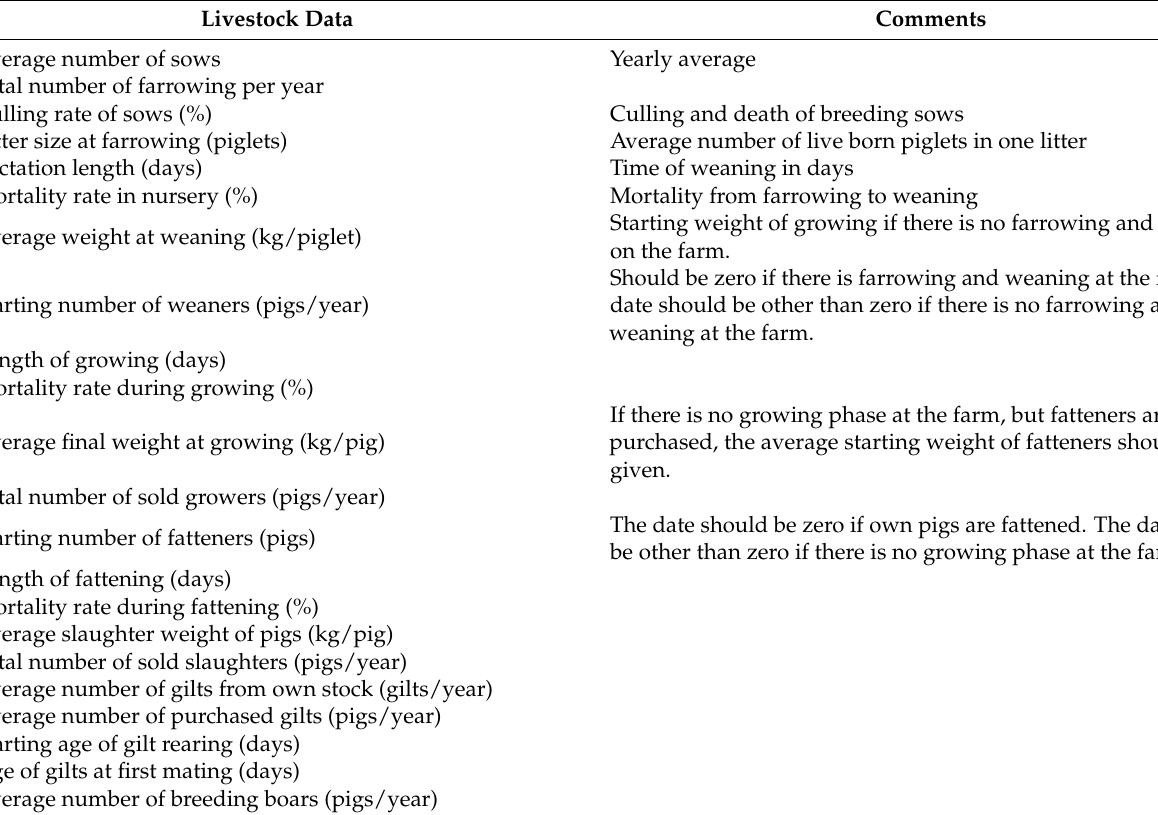
Table 1. Input data for